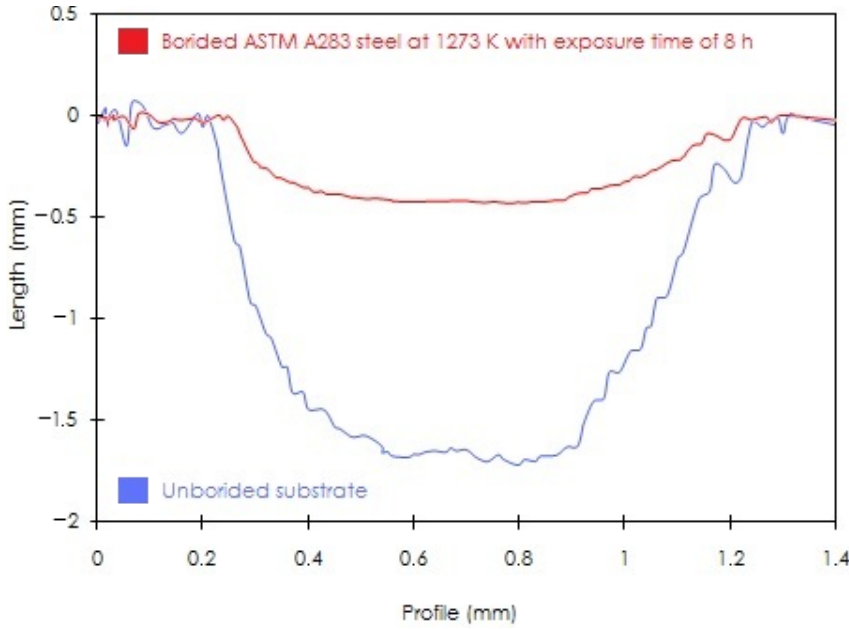
Figure 13. Profiles of wear tracks obtained on the surfaces of untreated substrate and boronized ASTM A283 steel for 8 h at 1273 K.